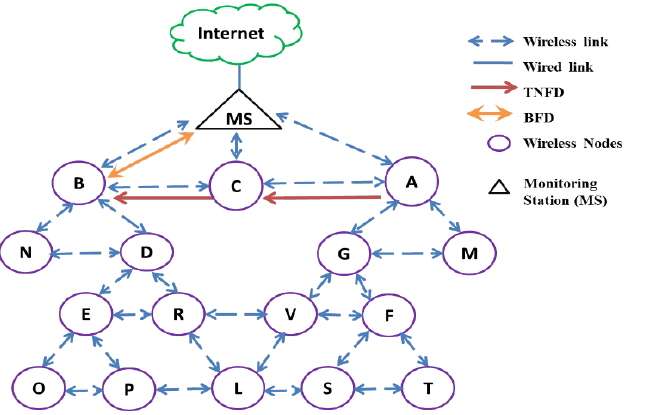
Figure 2. Proposed network model for AdHoc-FDMAC. The single alphabets in the figure are node labels. node